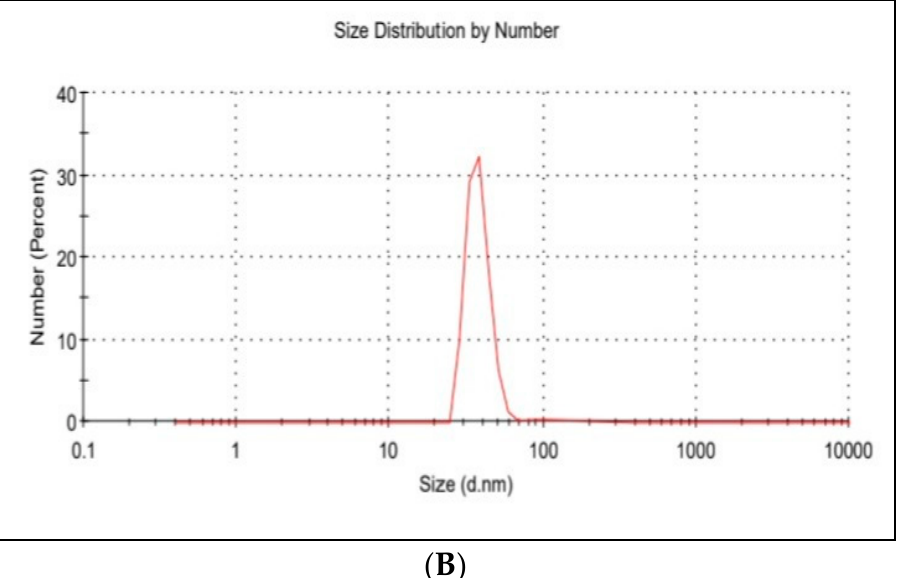
Figure 1. ( A ) Zeta potential distribution of silver nanoparticles. AgNP zeta potential is − 19.6 mV; ( B ) the size distribution by the intensity of AgNPs.